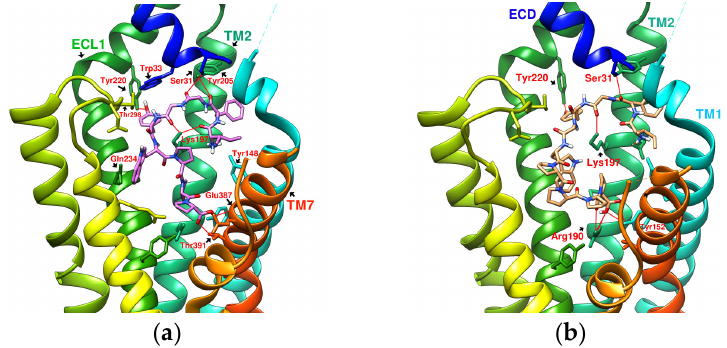
( a ) ( b ) Figure 12. ( a ) IFPGWPP N10 (−10.4 kcal/mol), ( b ) IFPRWPP N13 (−10.4 kcal/mol).